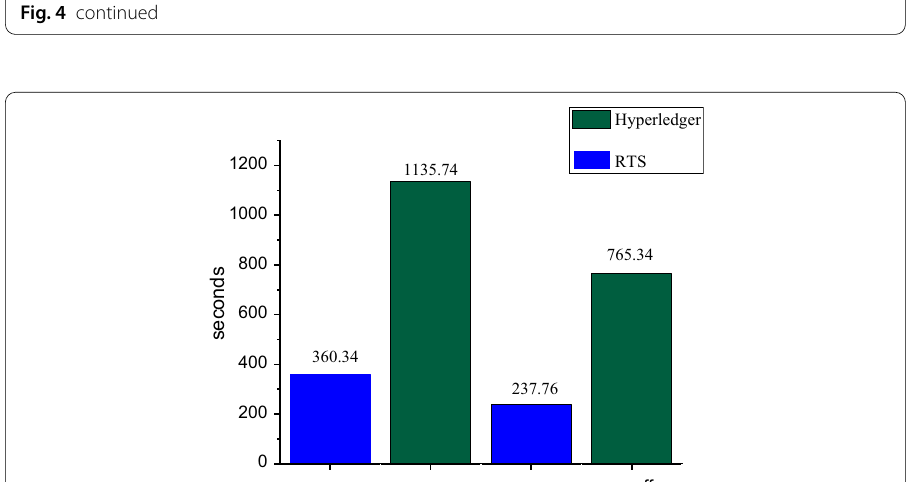
Fig. 5 Regular latency of RTS and Hyperledger with dissimilar consensus rulesets. This figure discover the regular latency performance of RTS and Hyperledger Fabric under situations in which the consensus technique is set up, with the homogeneous evaluation environment (i.e., transactions and device